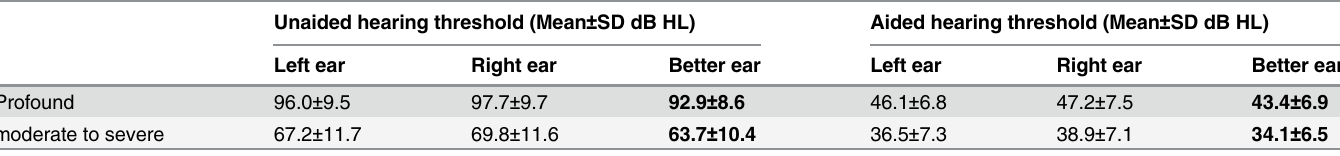
Table 2. Unaided and aided hearing thresholds of children participated in the current